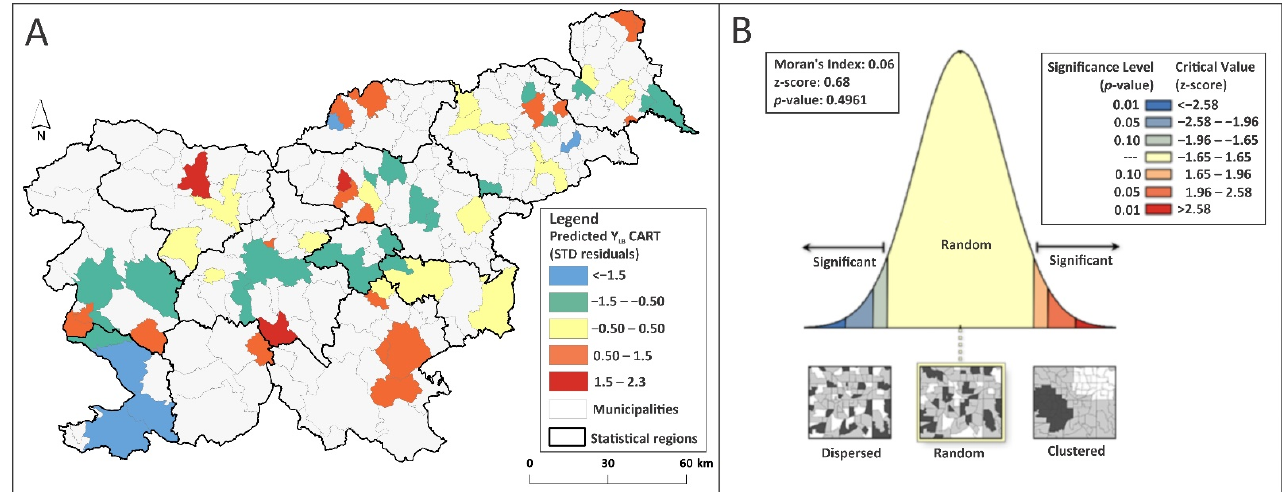
Figure 4. ( A ) CART predicted standardized residuals of Y LB test data; ( B ) The corresponding spatial autocorrelation test. Four LB foci were identified by calculating CART-predicted Y LB hot and cold